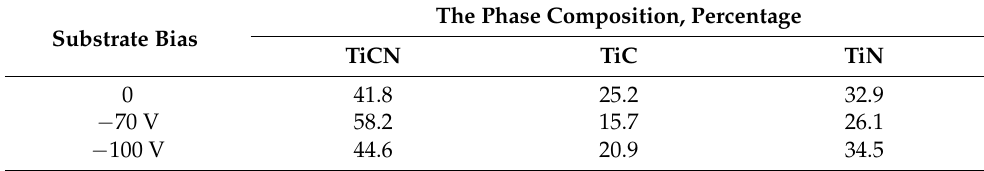
Figure 3. Effect of substrate bias at deposition TiCN coating on diffractograms. Table 2. Percentages of TiCN coating phases depending on U s .